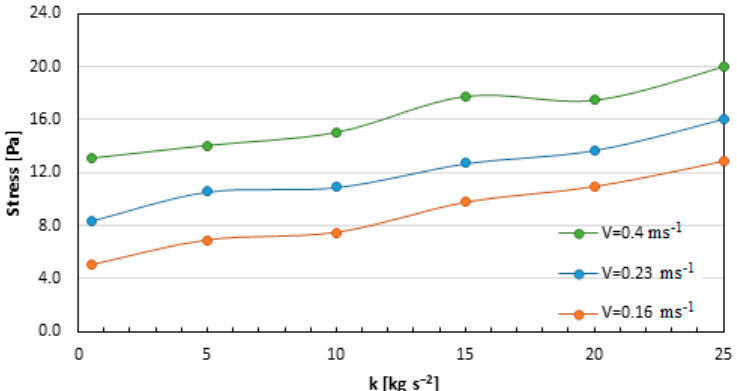
Figure 4. Stress (Frobenius norm of the stress tensor) with respect to 𝑘 and 𝑣 .